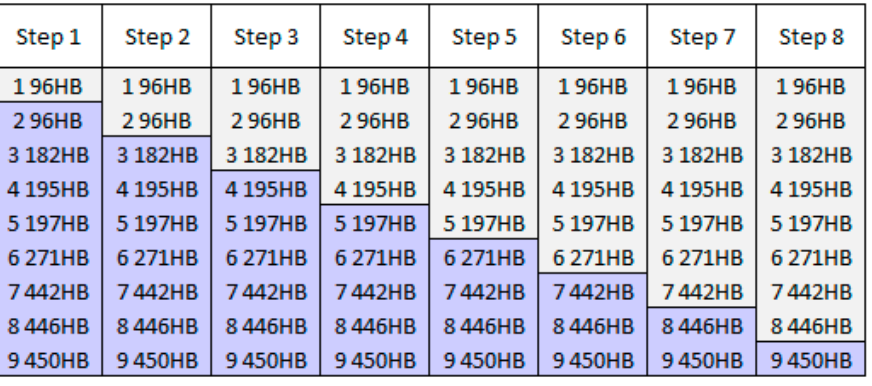
Figure 12. The step classification scheme into two subsets, grey and violet at every step. Table 4. Averaged results of classifications of ANNs in each step.